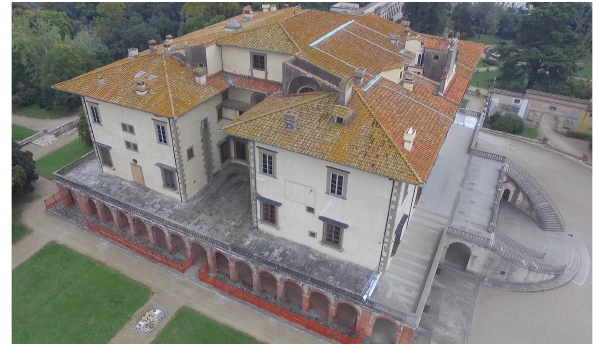
Figure 6. The Villa in Poggio a Caiano with the double circular staircase (image by the